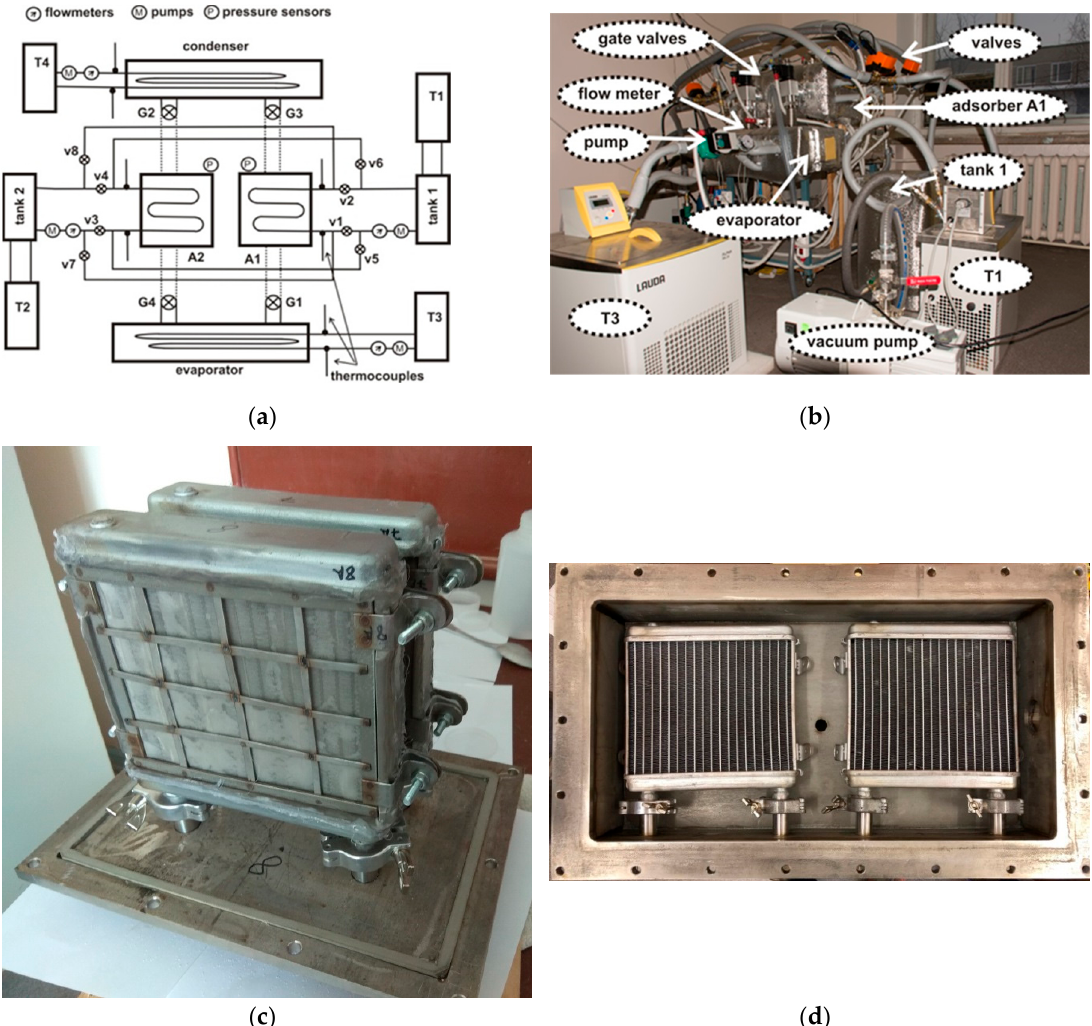
Figure 2. ( a , b ) The experimental rig. Note: T1–T4: thermocryostats; A1, A2: adsorbers; v1–v8: valves; G1–G4: gate valves. Adsorber ( c ) and evaporator ( d ) with installed heat exchangers.